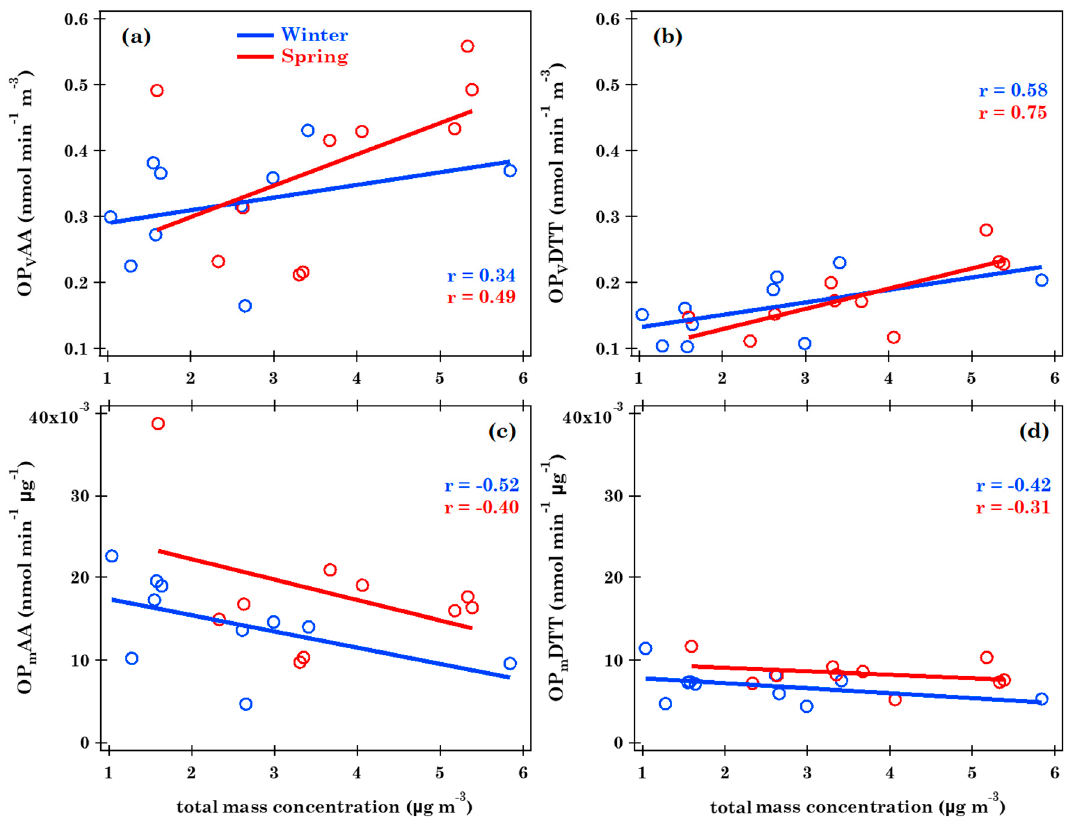
Figure4. Scatterplot of the( a ) ascorbic acid and( b ) dithiothreitol volume-normalized oxidative potential (OP V AA and OP V DTT, respectively) and the ( c ) ascorbic acid and ( d ) dithiothreitol mass-normalized oxidative potential (OP m AA and OP m DTT, respectively) as a function of the mass concentration of all the analyzed chemical elements (Al, As, Ba, Br, Ca, Cd, Cr, Cu, Fe, K, Mn, Mo, Ni, P, Pb, Rb, S, Se, Si, Sr, Ti, V, Zn, and Zr) for the 10 winter samples (blue circles) and the 10 spring samples (red circles). The correlation coefficients r and the corresponding fitting lines are also reported in each plot.